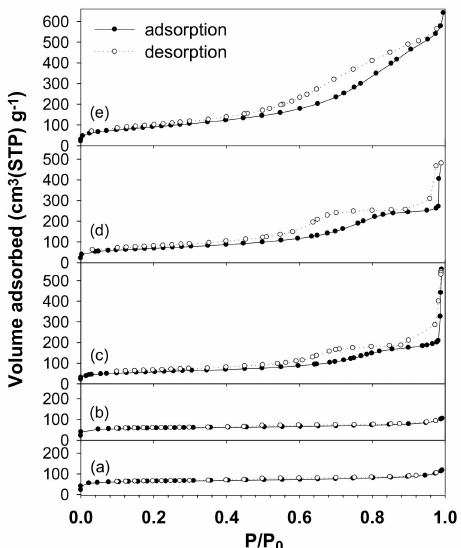
Figure 4. N 2 adsorption–desorption isotherms of ( a ) HZSM-48, ( b ) Pt / HZSM-48, ( c ) Pt / (HZSM-48 +